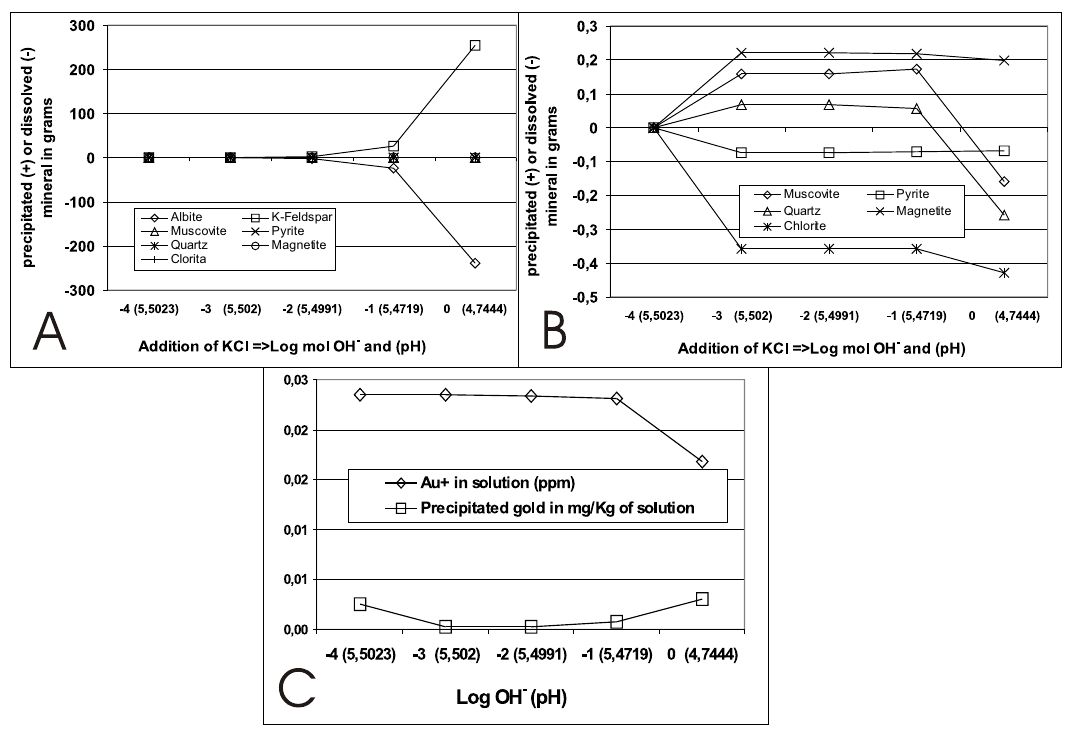
Fig. 7 – A – Variation in the precipitated (+) or dissolved (–) concentrations, in grams of minerals, by the addition of KCl at 300 ◦ C, with changes in (OH) − (alkalization). B – Detail of (A) between +0,3 and –0,5 grams of mineral. C – Variation of Au + in solution and precipitated gold (mg/Kg of solution) after the addition of KCl at 300 ◦ C, with changes in (OH) − (alkalization).